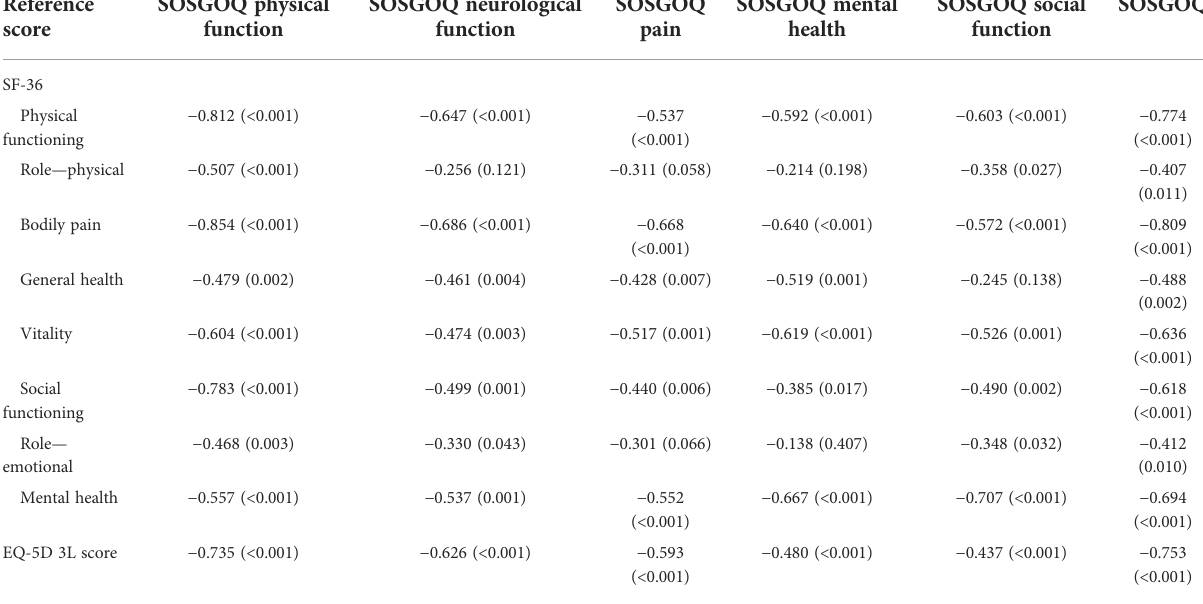
TABLE 4 Concurrent validity with the SF-36 and